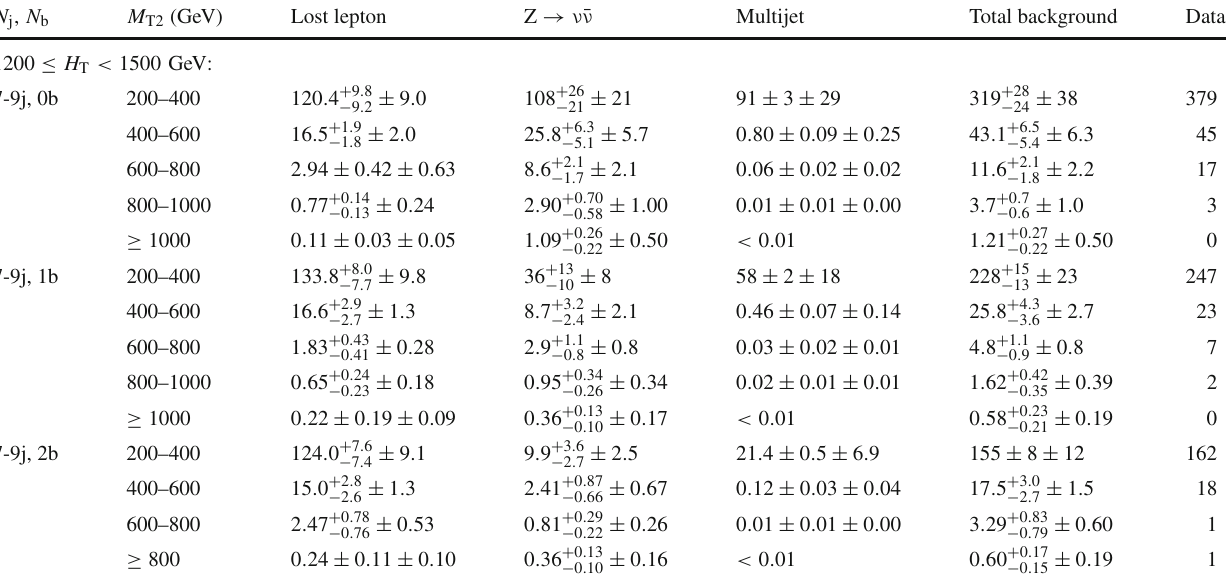
Table 21 Predictions and observations for the 31 search regions with 1200 ≤ H T < 1500 GeV, and 7 ≤ N j ≤ 9, or N j ≥ 10. For each of the background predictions, the first uncertainty listed is statistical (from